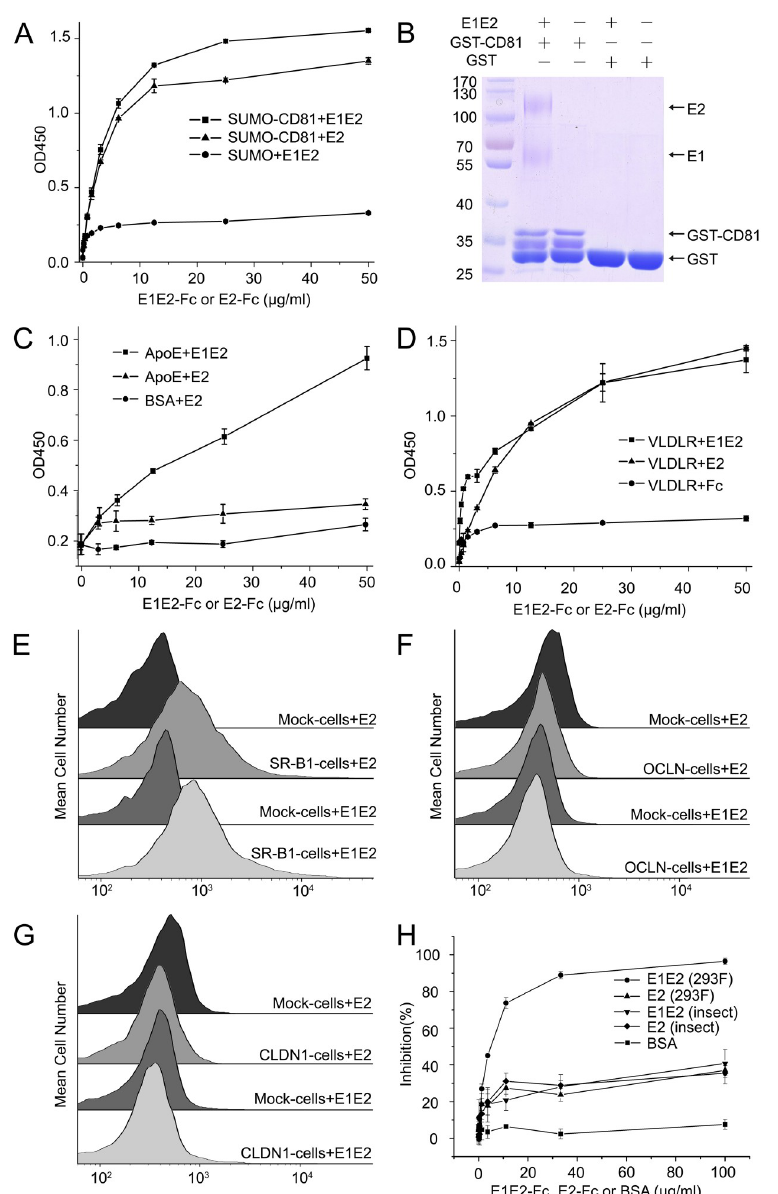
Fig 6. Interactions of HCV E1E2 heterodimer with the cellular receptors. (A) ELISA data show that both E1E2-Fc and E2-Fc bind to CD81. (B) GST pull-down assays show that E1E2-Fc binds to CD81. (C) ELISA data show that E1E2-Fc binds to ApoE, whereas E2-Fc has no obvious binding affinity to ApoE. (D) ELISA data show that E1E2-Fc and E2-Fc bind to VLDLR similarly. (E) FACS data show that both E1E2-Fc and E2-Fc bind to the SR-B1 transfected HEK293 cells. (F) Both E1E2-Fc and E2-Fc show no binding affinity to the OCLN transfected HEK293 cells. (G) Both E1E2-Fc and E2-Fc show no binding affinity to the CLDN1 transfected HEK293 cells. (H) Both E1E2-Fc and E2-Fc can block the infection of HCVcc. The ELISA data shown in (A), (C) and (D) are representative of three repeated experiments and presented as mean ± SD. The viral infection blocking data shown in (H) are representative of three repeated experiments and presented as mean ±